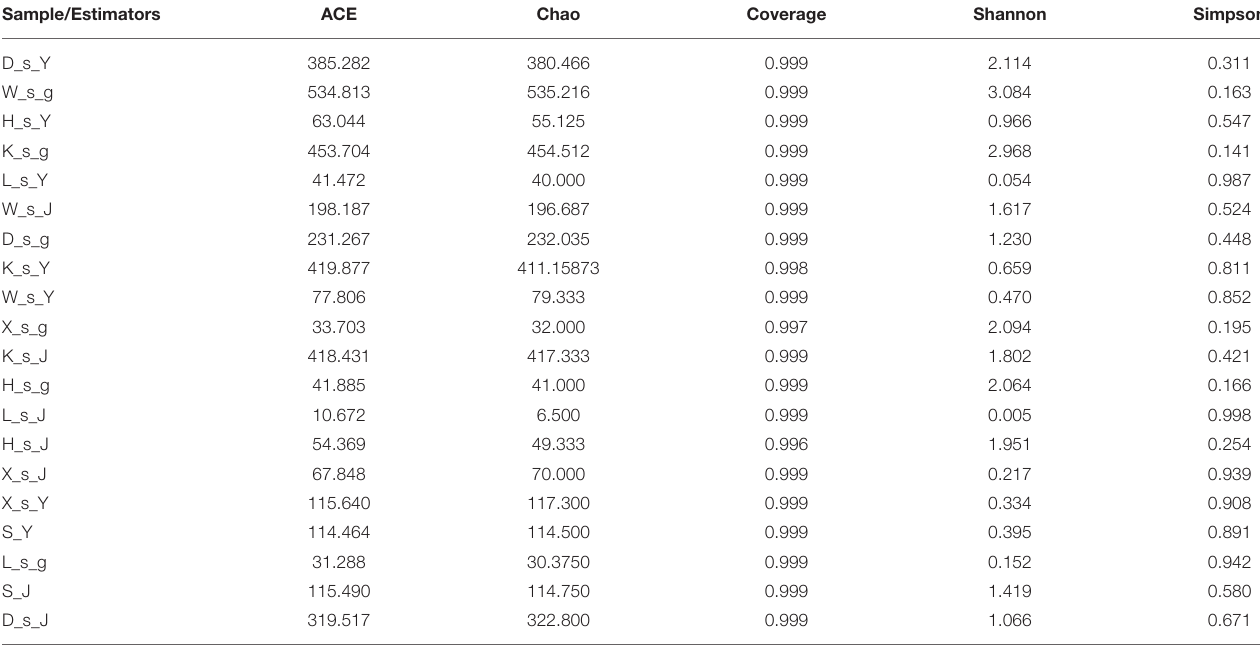
TABLE 5 | Alpha- diversity indexes of fungal communities based on high-throughput DNA sequencing of different samples. Sample/Estimators ACE Chao Coverage Shannon